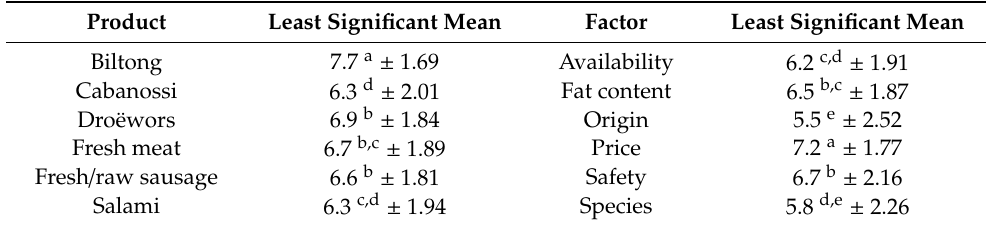
Table 6. Least significant means (±SE) of the preference and factors influencing the purchase of game meat products within the sample population.